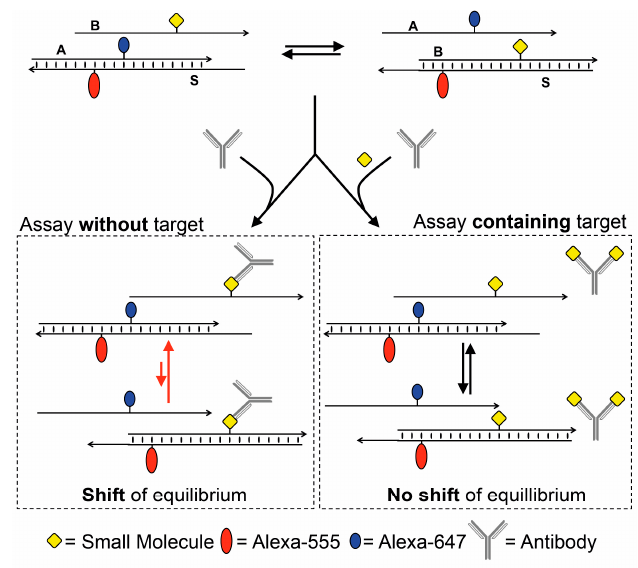
Figure 1. Overview of the strand displacement competition assay. DNA strands A (conjugated to Alexa-647), B (conjugated to digoxigenin), and S (conjugated to Alexa-555). The two toeholds on S are complimentary to sequences on A and B, respectively. The constant region on S is complimentary to both A and B. In the absence of an anti-digoxigenin antibody, the system obtains a low Förster resonance energy transfer (FRET) state, and a high FRET state in the presence of an antibody. If an antibody binds to free digoxigenin or digoxin, it is blocked and will not influence the equilibrium.